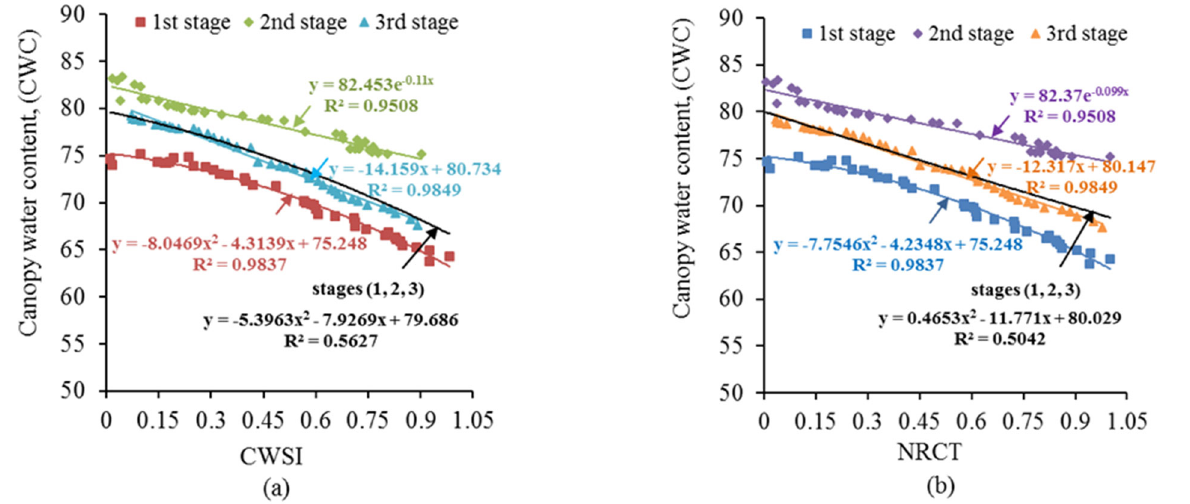
14 of 23 Table 5. Various architectures of BPNN model based on GLCMF extracted from digital images with MSE, RMSE, MAPE (%), Acc, and R 2 in training, cross ‐ validation, and test set. Where * refers to best ‐ combined GLCMF at the smallest value of RMSCV. 3.1.3. Thermal Indicators (T) The rice plants, at three growth stages, were grown with four levels of irrigation un ‐ der outdoor conditions. The temperature of the rice canopy was affected by the water stress. The temperatures of non ‐ water stressed and water ‐ stressed canopy were 31°C and 38°C at the 1st stage, 37°C and 49.1°C at the 2nd stage, and 22°C and 34.07°C at the 3rd stage, respectively. We exploited the previous temperatures for computing the two ther ‐ mal indicators: CWSI and NRCT. The relationship of both CWSI and NRCT with the CWC of rice at each growth stage is designated in Figure 8. It was observed to be inversely related, and the R 2 at each stage independently was higher than the R 2 at three stages. By applying ANN with thermal indicators, the prediction formula to compute the CWC at any stage of rice growth was explored with high accuracy. The neural network outputs with thermal indicators at the 1st and 2nd loop are illuminated in Table 6. It depicts the optimal parameters of the T ‐ based BPNN model and its outputs (R 2 , MAPE, RMSE, MSE, and Acc) through cross ‐ validation, training, and test set. The results approved that the